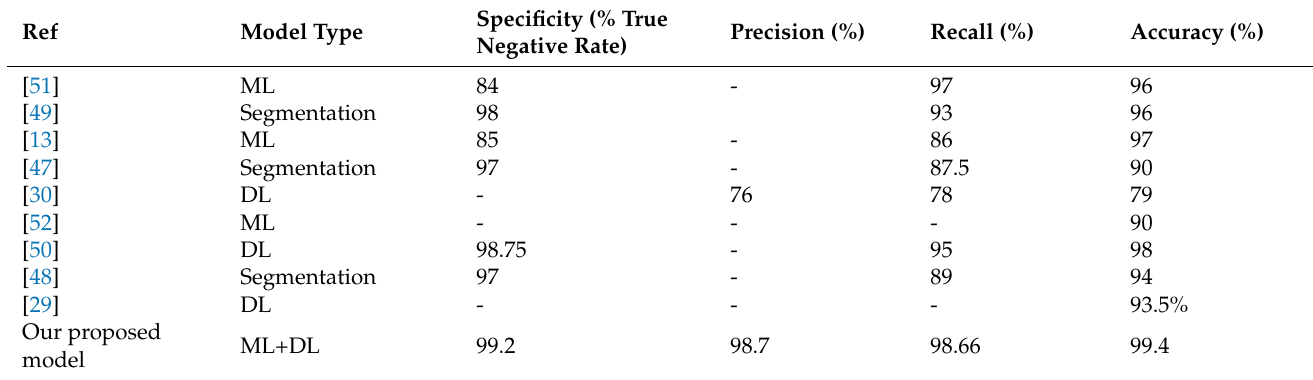
Table 4. Comparison with existing techniques.